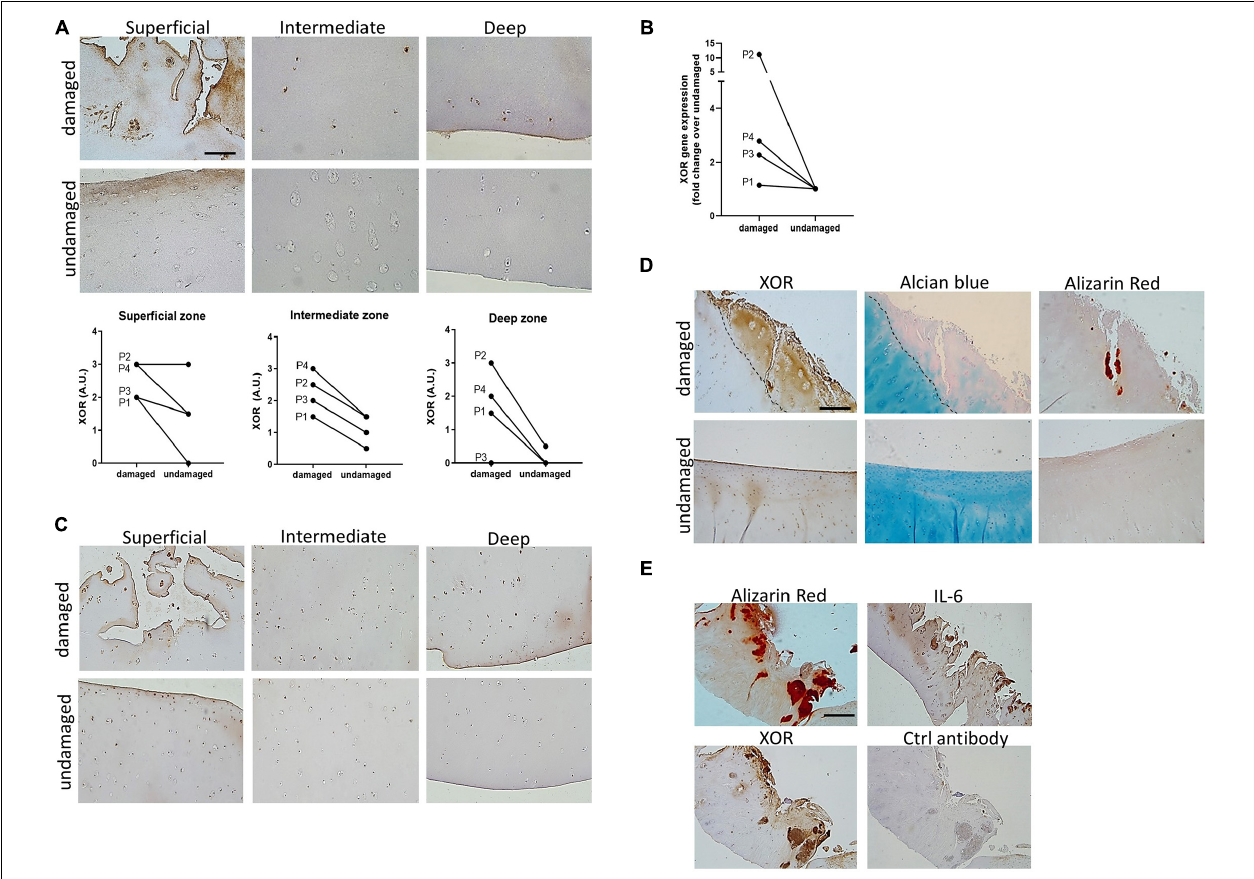
FIGURE 4 | Cartilage XOR expression correlates with cartilage damage and calcification in OA. (A) XOR immunohistochemical staining in superficial, intermediate and deep zone of macroscopically damaged and undamaged cartilage from end-stage osteoarthritis patients. One representative picture from one out of four patients is shown. Scale bar 200 µ m. Graph represent quantification of XOR staining in damaged and undamaged cartilage from four OA patients (named P1, P2, P3, and P4). (B) qRT-PCR analysis of XOR gene expression in damaged and undamaged cartilage from patients in point (a). (C) IL-6 immunohistochemical staining in superficial, intermediate and deep zone of macroscopically damaged and undamaged cartilage from end-stage osteoarthritis patients. One representative picture from one out of four patients is shown. Scale bar 200 µ m. Sections are consecutive to those in panel (A) . (D) XOR immunohistochemical staining in cartilage and consecutive sections stained with Alcian blue staining for glycosaminoglycans and Alizarin Red staining for calcium-containing crystals. For each staining, one representative picture from one out of four patients is shown. Scale bar 400 µ m. (E) Alizarin Red staining for calcium-containing crystals in cartilage and consecutive sections stained with IL-6 and XOR immunohistochemistry or a control (Ctrl) antibody. For each staining, one representative picture from one out of four patients is shown. Scale bar 800 µ